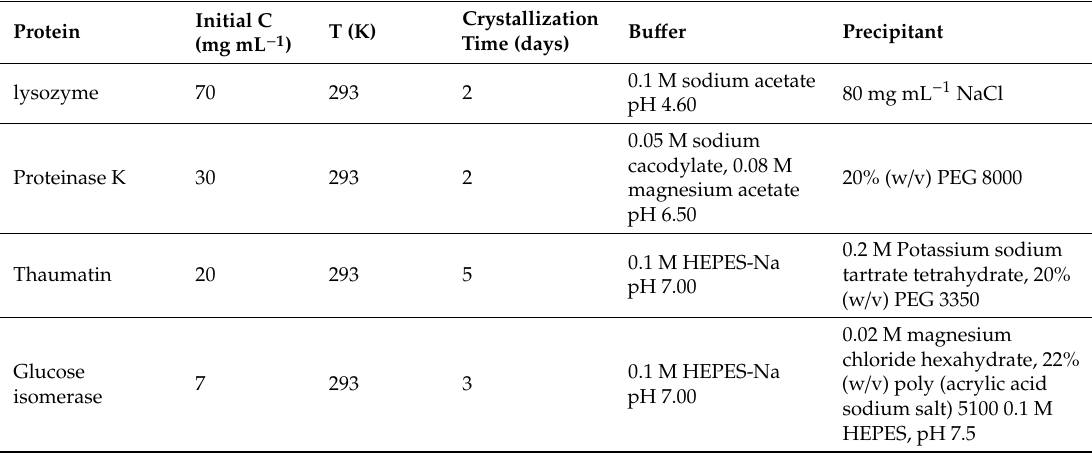
Table 1. Crystallization conditions of proteins researched in the crystallization